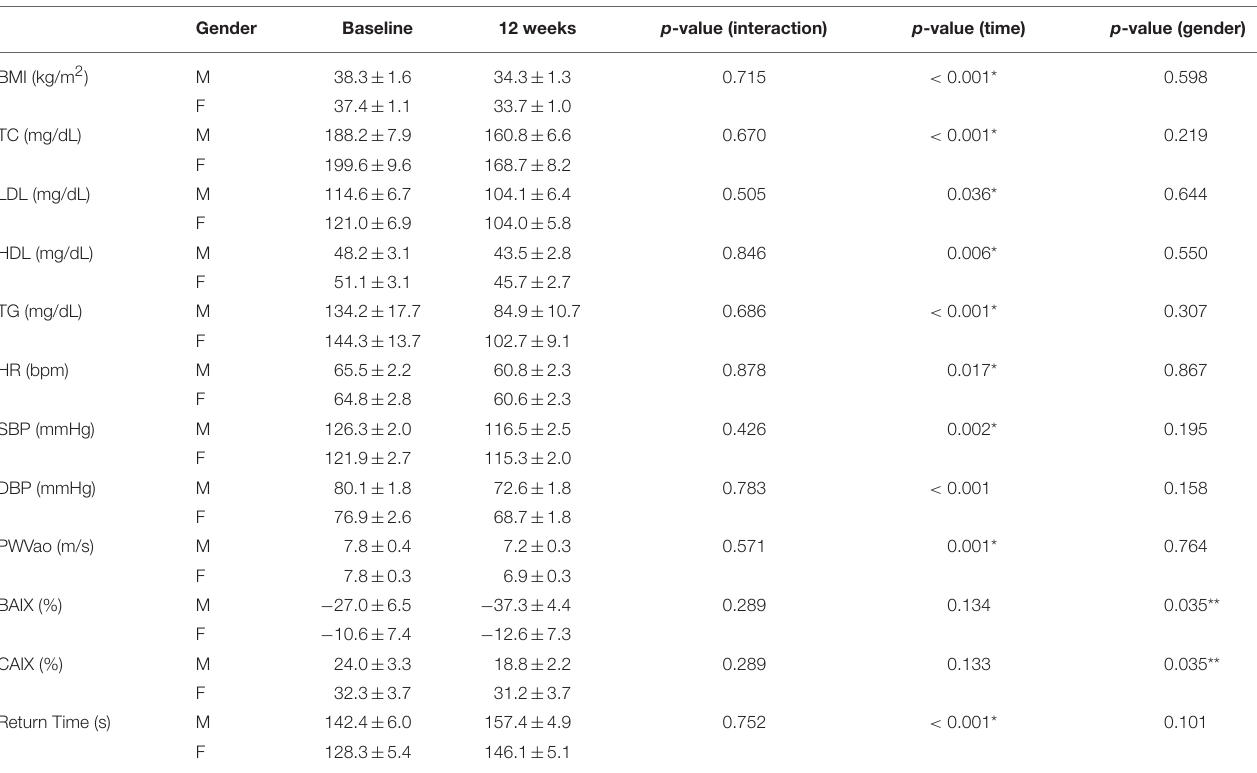
TABLE 4 | Results of weight loss phase (Phase 1).